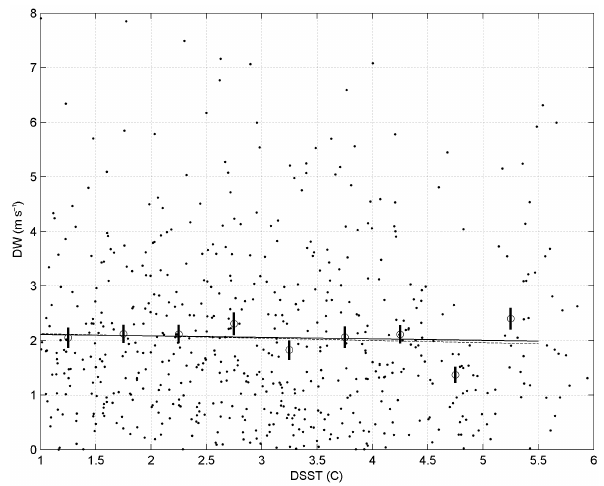
Figure 11. Scatter plot of SST perturbation (DSST) vs. absolute value of wind speed decrease (DW) in ms − 1 on each side of the eddy relative to wind conditions over the core of the eddy for cases when the wind was stronger above the core of eddies than on each of their sides, and for SST perturbation from the surrounding ocean >1 ◦ C and wind is parallel to the eddies. Solid line is a linear fit. The circle represent the means within each 1 ◦ C bin and the error bars represent ± 1 standard deviation of the wind differences within each bin divided by the square root of the number of sample within each bin. The dashed line is a linear fit of the means within the